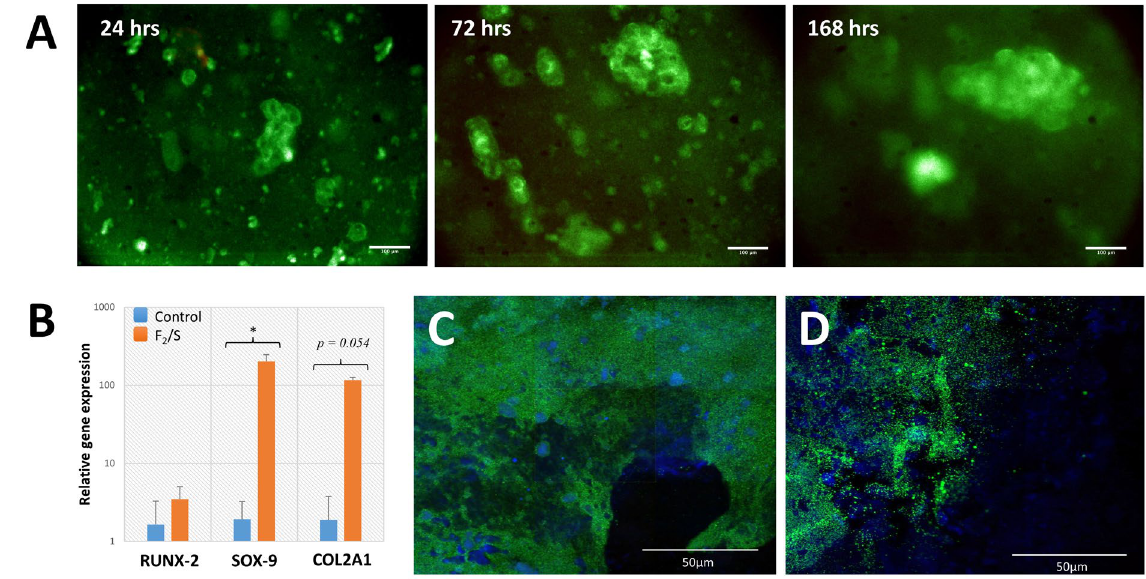
Figure 2. ( A ) Human adipose derived pericyte cultured within Fmoc-F 2 /S hydrogels. Cells were encapsulated in F 2 /S hydrogels and maintained in unsupplemented basal media for up to 1 week. Cells were checked for viability by fluorescence detection of Syto 10 (green) for live cells and ethidium homodimer-1 (red) for dead cells after 1, 3 and 7 days. ( B ) QRT-PCR analysis for gene expression of pericyte cells cultured within 15.5 kPa Fmoc-F 2 /S hydrogels. Cells were assessed for the production of chondrogenic biomarkers RUNX- 2, SOX-9 & type II collagen (COL2A1) after one week in culture. ( C & D ) Confocal microscopy images of immunofluorescently stained F 2 /S hydrogels cultured with pericytes for 28 days. Pericytes were checked for chondrogenic development by staining for aggrecan production ( C ) and type II collagen ( D ) both ascertained through green fluorescence. Cell populations are indicated by staining the cell nucleus with DAPI (blue). The images are mosaics of a 3 × 3 tile scan, each acquired from random positions of the hydrogel. Scale bar in A is 100 µ m, in C & D is 50 µ m. In B, Error bars denote the standard error where p < 0.05 as calculated using unpaired student